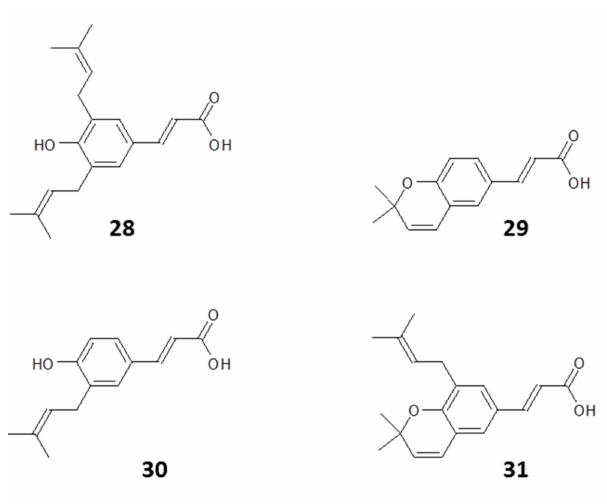
Figure 5. Structures of some phenolic compounds from Brazilian propolis active against T. cruzi .